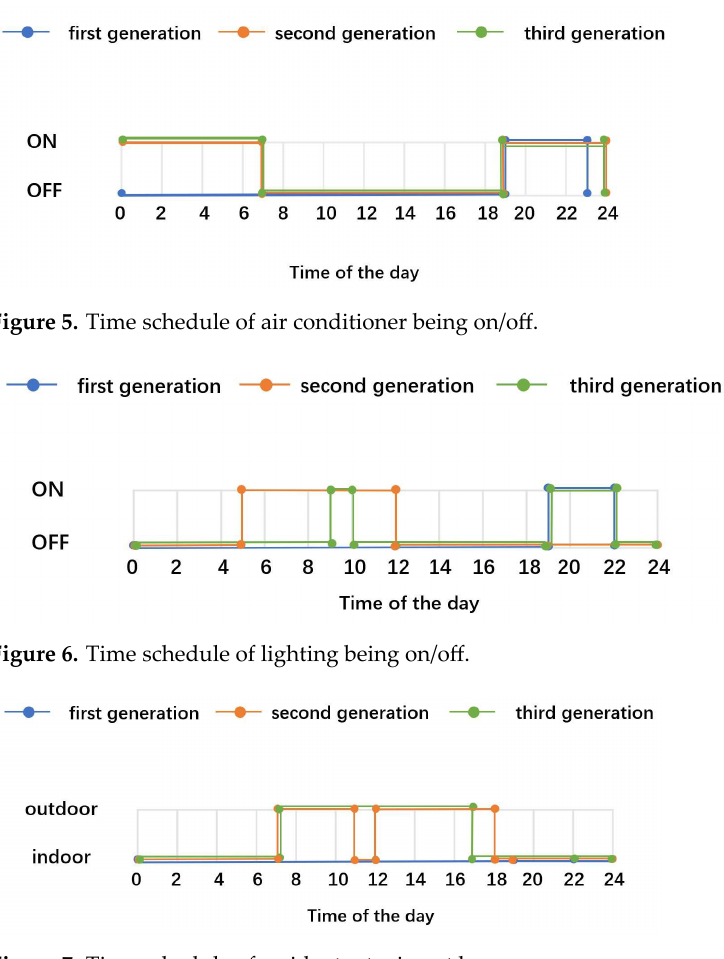
Figure 7. Time schedule of residents staying at home.